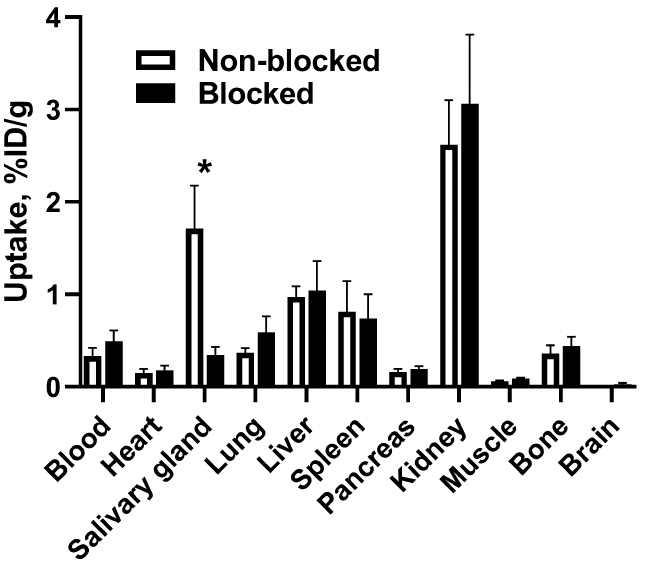
Figure 4. Effect of blocking of Na/I-symporter on biodistribution of 188 Re-ZHER2:41071 in NMRI mice at 4 h p.i. The tissue uptake values were calculated as the percentage of injected dose per gram (%ID/g). Data are presented as an average ( n = 4) value ± SD. Asterisk (*) indicate significant differences ( p < 0.05) between blocked and non-blocked groups.